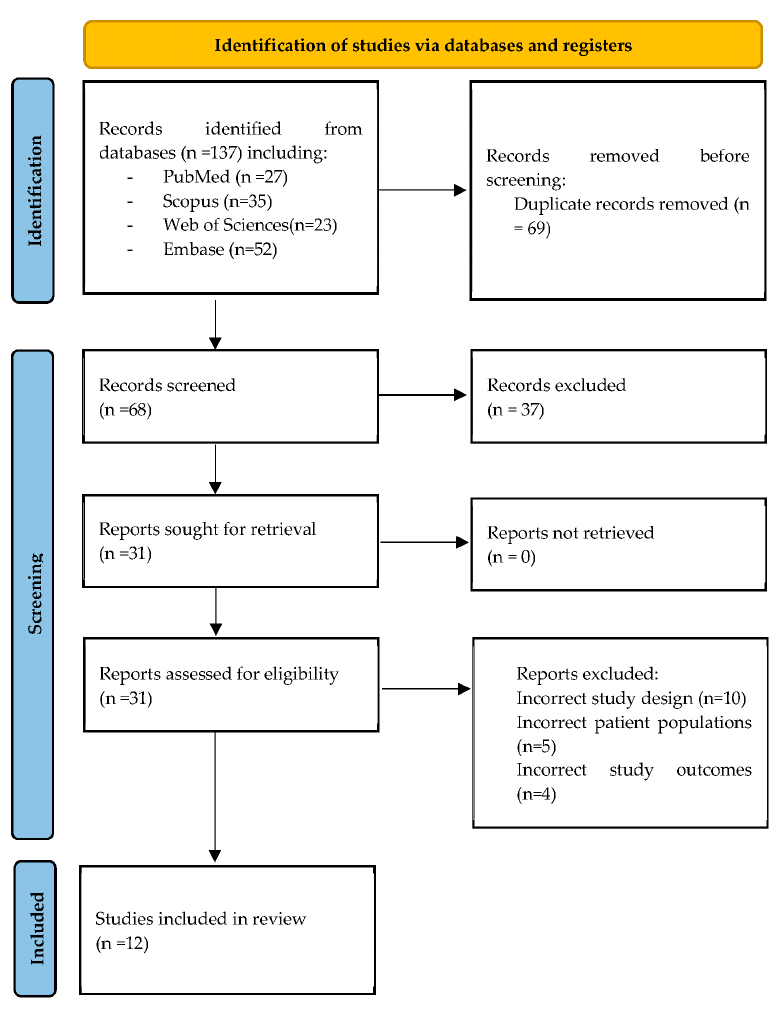
Figure 1. PRISMA flow chart of the studies selection process.